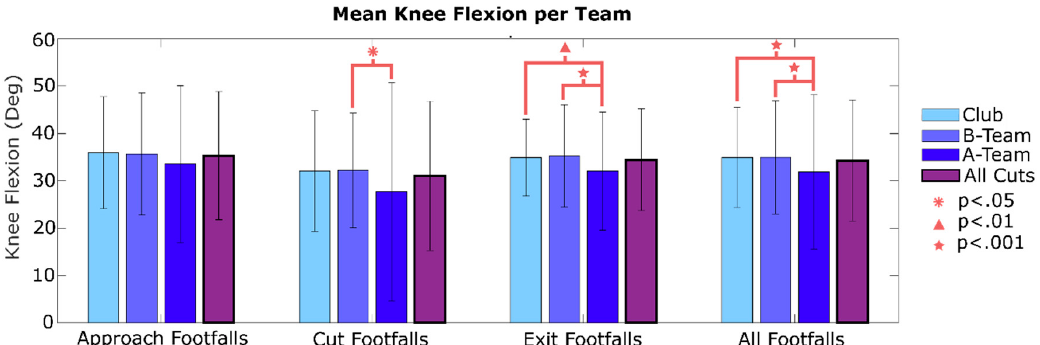
Figure 10. Mean knee flexion during ground contact for cutting footfalls for each team, and for all cuts collectively. Mean values for each phase of the cut, in addition to all cutting footfalls, are shown. A-team players tend to cut with lower knee flexion throughout the cutting maneuver.